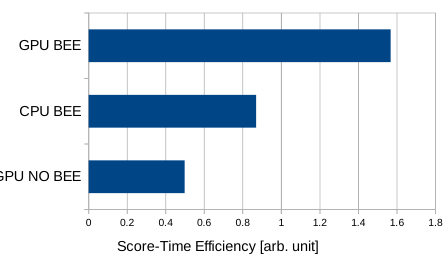
Figure 14. Comparison of Score-Time Efficiency between using parallel HSA (GPU BEE), parallel exhaustive search (GPU NO BEE) and sequential HSA (CPU BEE).